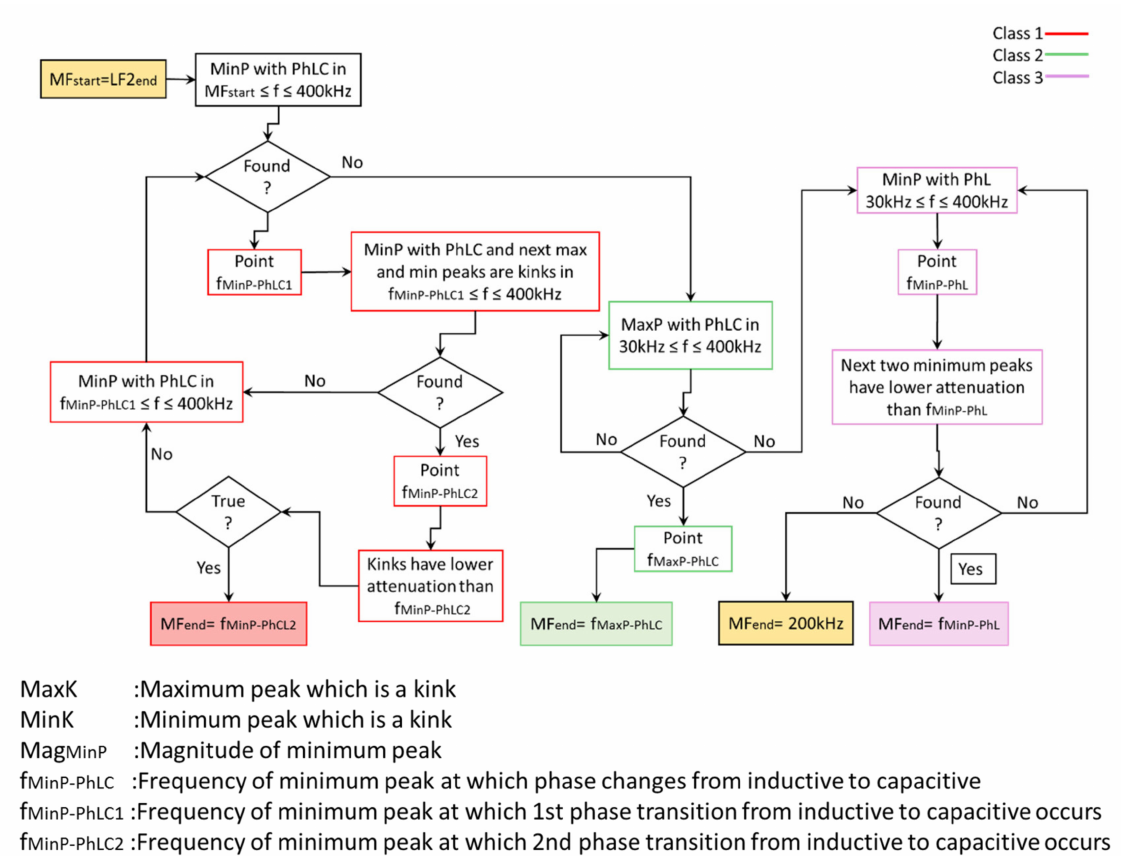
Figure 10. Workflow of the algorithms for identification of the medium frequency sub-band (MFB end ).